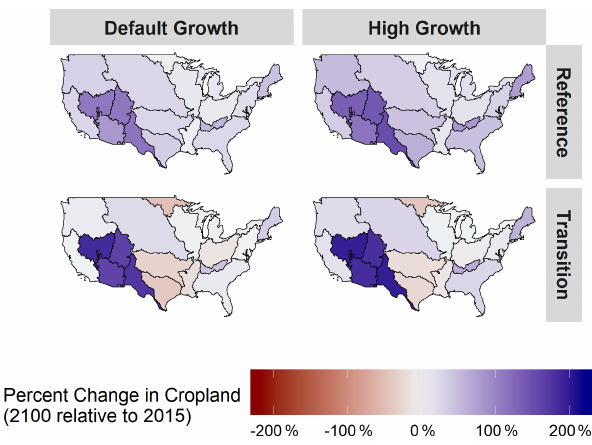
Figure 11. Percentage change in cropland allocation in 2100 rel- ative to 2015 by water basin and scenario. Red shades indicate a reduction in cropland allocation, while blue shades indicate an in- crease in